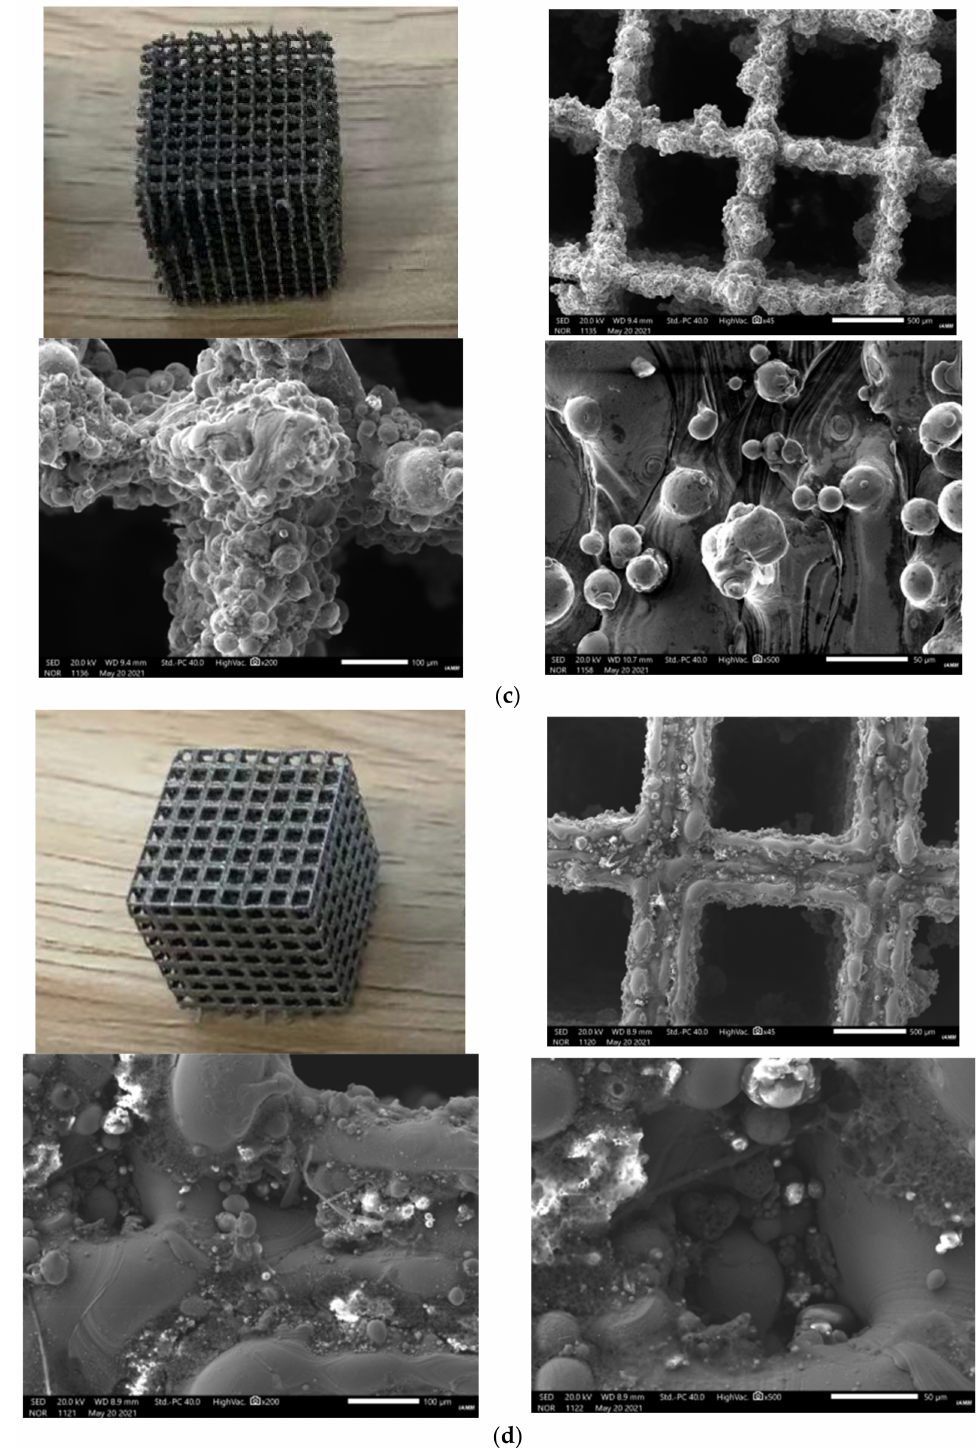
Figure 11. ( a ) Unoptimized sheet stainless steel part and SEM. ( b ) Unoptimized cubic stainless- steel part and SEM. ( c ) Unoptimized porous stainless-steel part and SEM. ( d ) Optimized porous stainless-steel part and